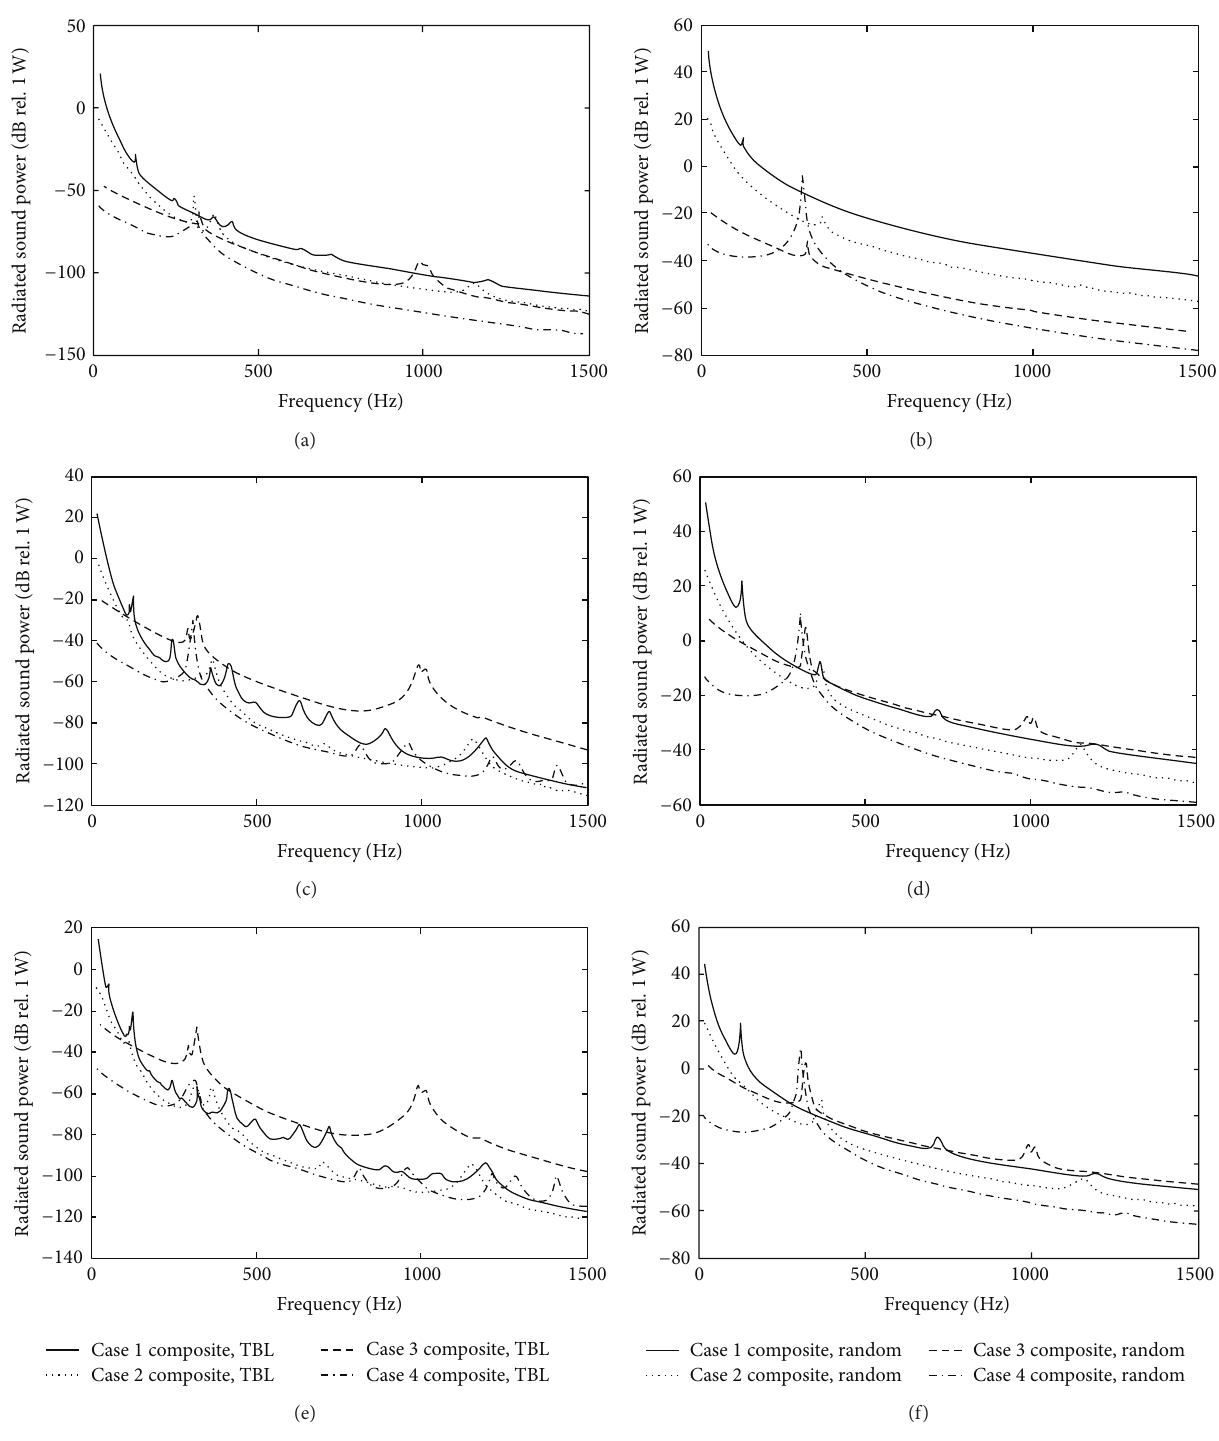
Figure4:Radiatedsoundpowerresultsforthecompositepanels:(a)and(b)overallpanelRSP;(c)and(d)RSPnearsurfacelocation (𝑥 1 ,𝑦 1 ) = (0.5𝑎, 0.5𝑏) ; (e) and (f) RSP near location (𝑥